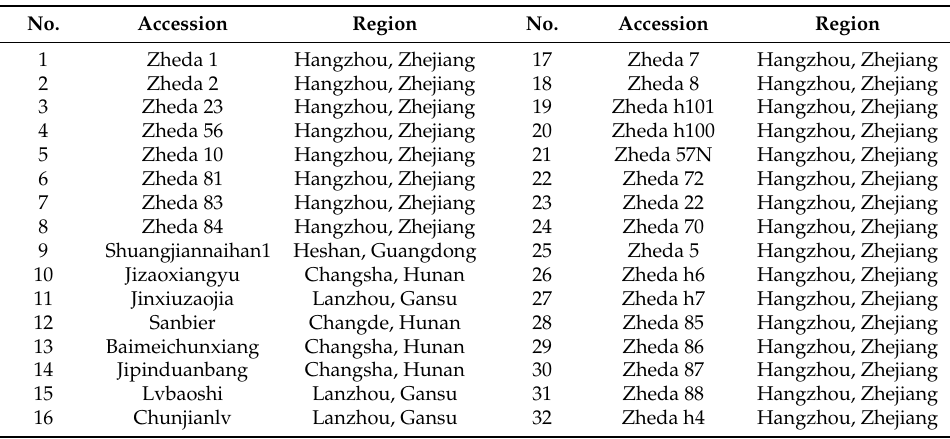
Table 7. The 32 Luffa accessions included in present